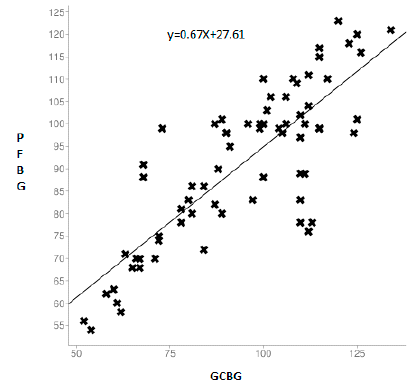
Figure 2. Scatter plot of the linear relationship between the glucose measurements of the gingival blood and capillary finger-stick method in the non-diabetic group. and capillary finger-stick method in the non-diabetic